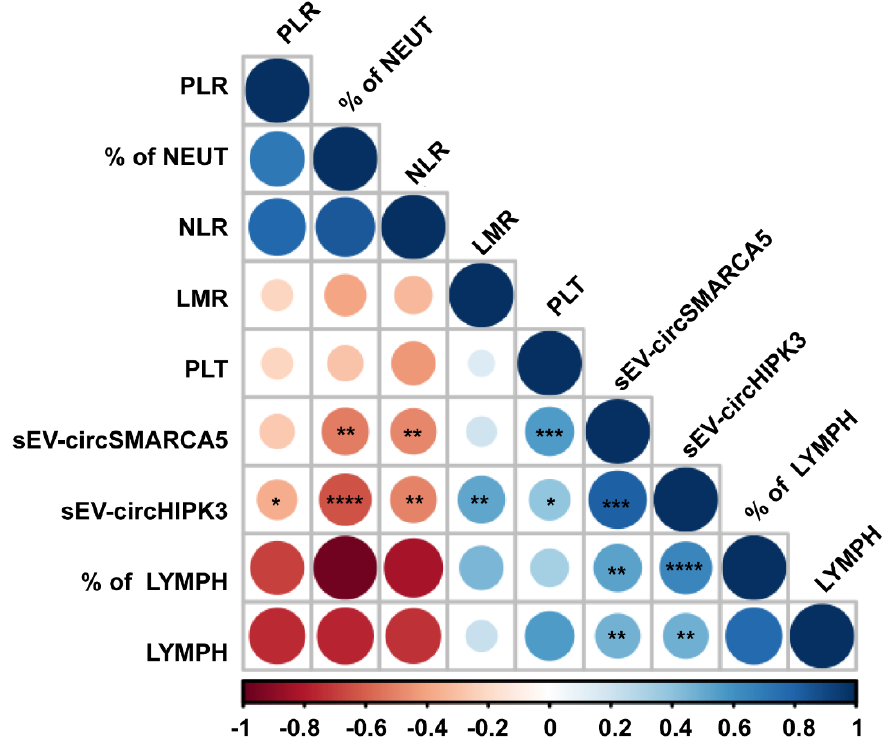
Figure 3. Correlogram showing correlations between the expression of sEV-derived circSMARCA5 and circHIPK3 and hematological data. Scale-bar shows r-values calculated through Pearson’s correlation test. The size of each circle is directly proportional to the statistical significance that is shown for some correlation of interest through one (* p -value < 0.05), two (** p -value < 0.01), three (*** p -value < 0.001) or four (**** p -value < 0.0001) asterisks. (NEUT = Neutrophils, PLT = Platelet count, LYMPH = Lymphocytes).